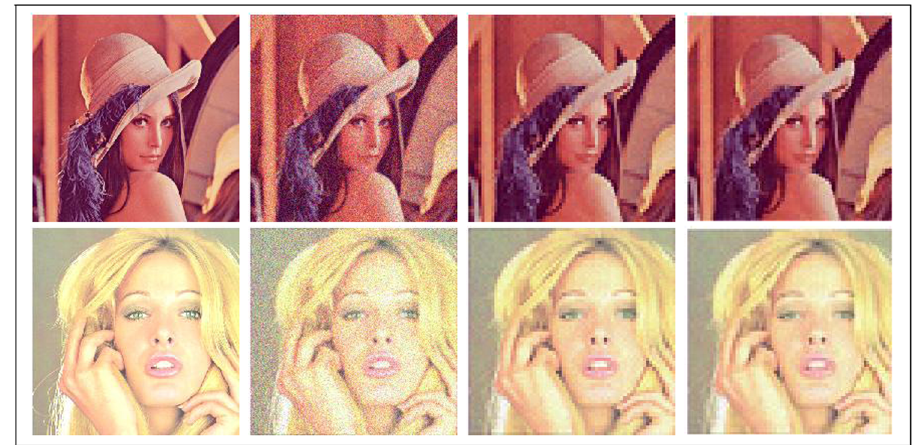
Figure 6: Restoration of test images, 512 512 × Lenna ( Top ) and 720 576 × Ti ff any ( Bottom ) . From the left: The original image, the blurred image with 10% noise, the restored image by CGD and DLPA ( right )